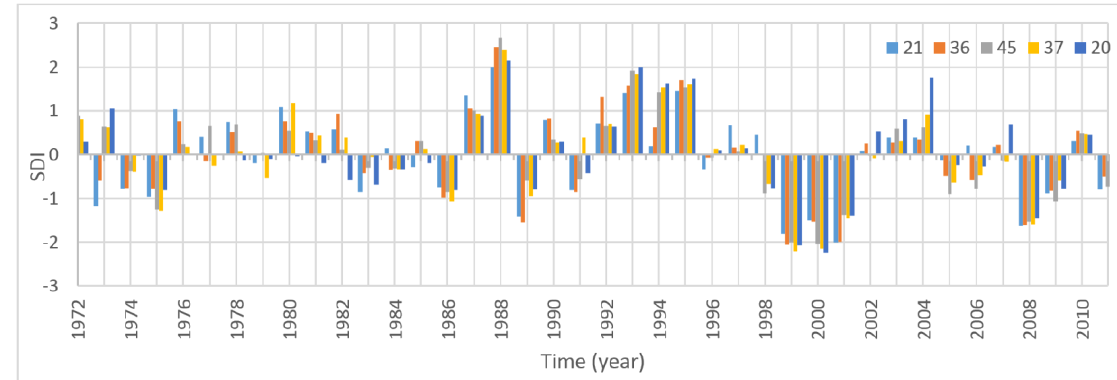
Figure 8. SDI-12 series of stations 21, 36, 45, 37, and 20 for yearly periods.